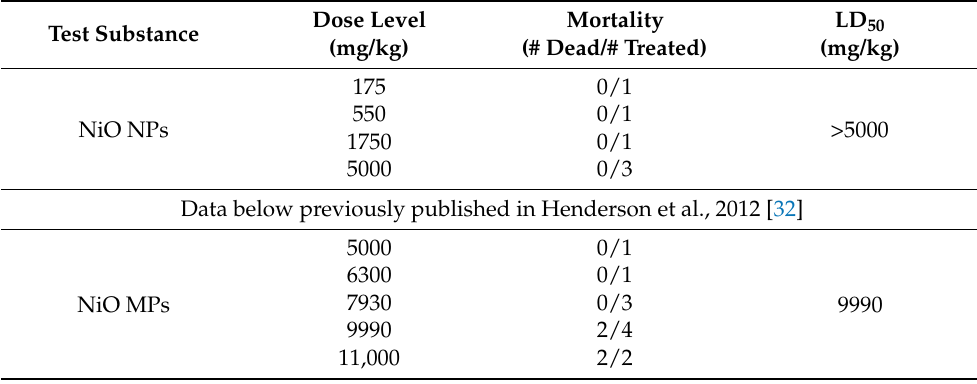
Table 3. Acute oral exposure